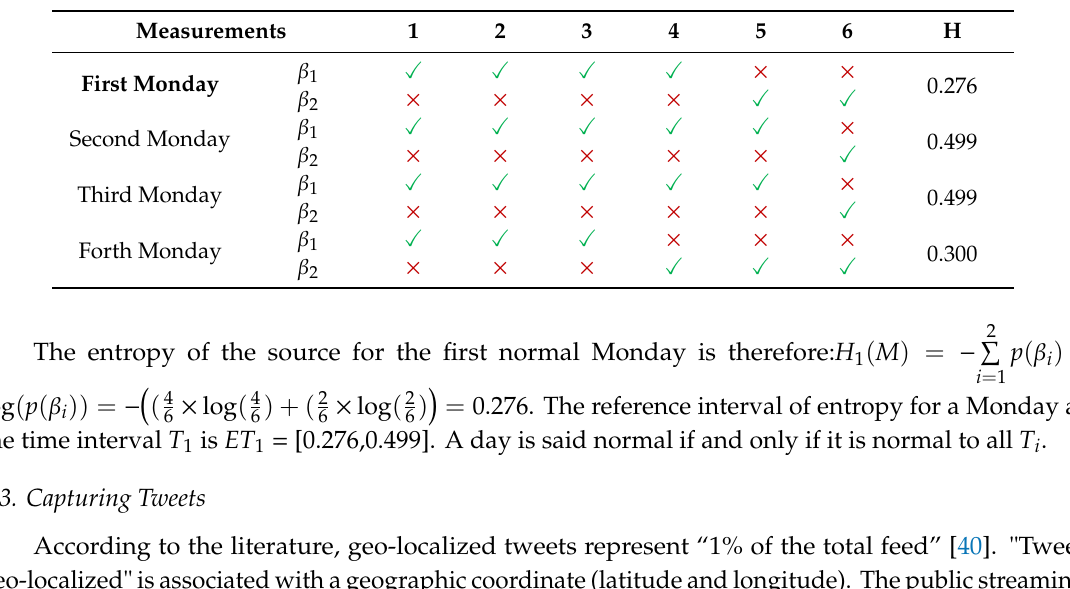
Table 1. Example of the reference interval of